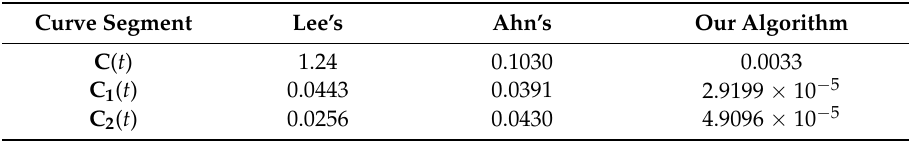
Figure 5. Approximation error performance. ( a ) After the first iteration; ( b ) After four iterations. Table 1. Comparison between Lee’s, Ahn’s, and our algorithms in terms of the error bound. Curve Segment